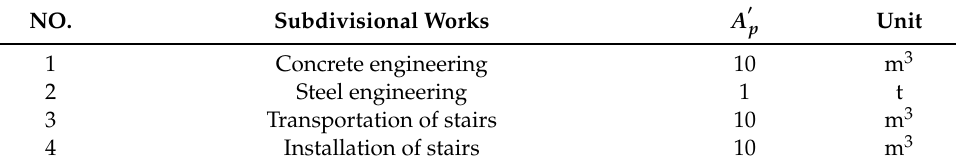
Table 7. Quota Engineering Quantities of the Prefabricated Stair.